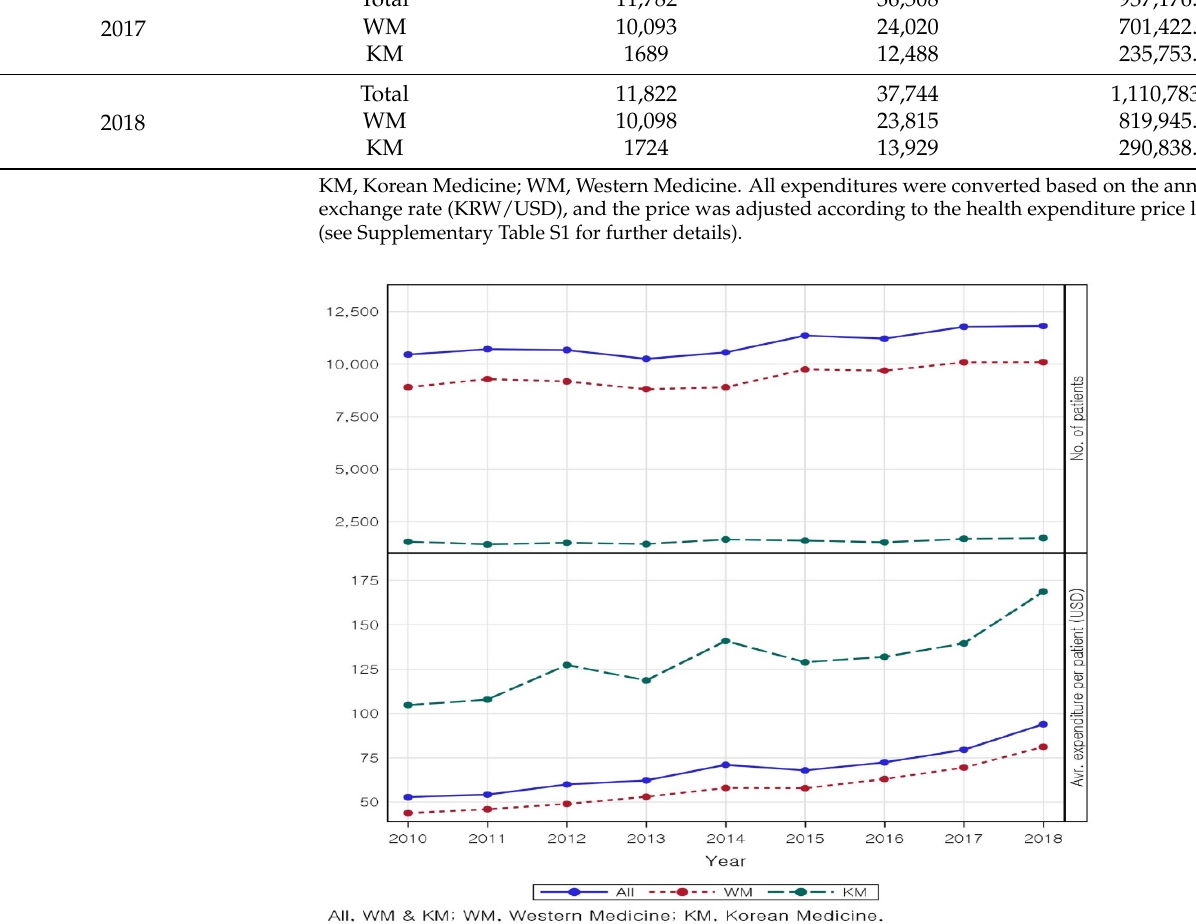
Figure 2. Increase in patients with Tinnitus; average expenditure per patient in WM and KM. All expenditure was converted based on the annual average exchange rate (KRW/USD), and prices were adjusted according to the health expenditure price level in 2018 (see Supplementary Table S1 for details).